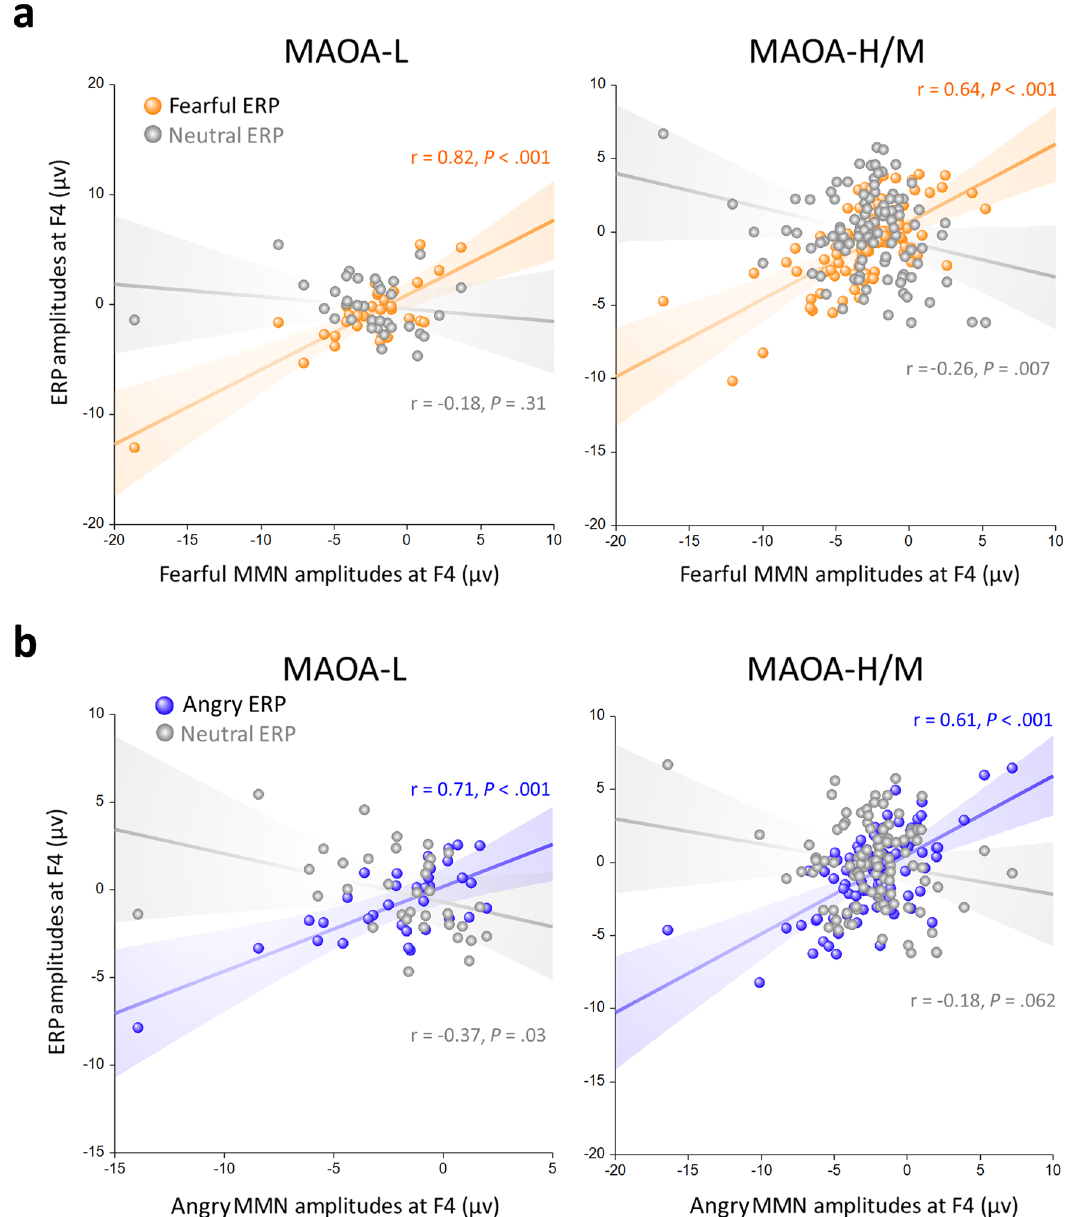
Fig. 4 Emotional MMN as a function of neutral, angry and fearful ERPs in participants who possess different MAOA alleles. a Fearful MMN . In participants with MAOA -low (combined men and women, n = 34, left panel), fearful MMN was only positively correlated with the amplitudes of fearful ERP ( R 34 = 0.82, P < 0.001) but not correlated with neutral ERP ( R 34 = − 0.18, P = 0.31). However, in the rest of participants who have MAOA -H or MAOA -I (combined men and women, n = 106, right panel), fearful MMN was positively correlated with the amplitudes of fearful ERP ( R 106 = 0.64, P < 0.001) and negatively correlated with neutral ERP ( R 106 = 0.26, P = 0.007) b. Angry MMN . In participants with MAOA- low (combined men and women, n = 34), angry MMN was positively correlated with the amplitudes of angry ERP ( R 34 = 0.71, P < 0.001) and negatively correlated with neutral ERP ( R 34 = − 0.37, P = 0.03). However, in the rest of participants who have MAOA -H or MAOA -I (combined men and women, n = 106), angry MMN was only positively correlated with the amplitudes of angry ERP ( R 106 = 0.61, P < 0.001) but not correlated with neutral ERP ( R 106 = − 0.18, P = 0.06). Source data are presented in Supplementary Data